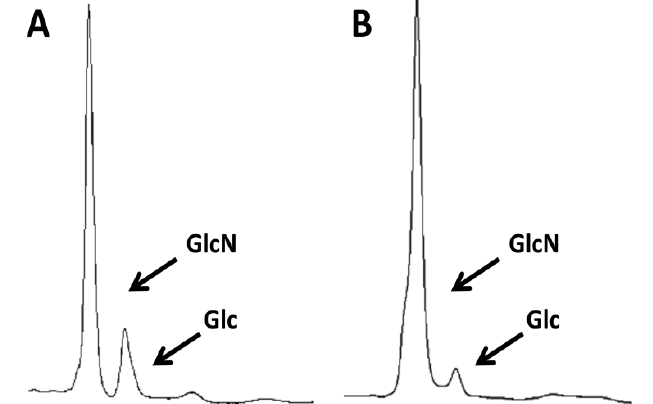
Figure 1. Purity of commercial crab chitin before and after treatment under alkali and acid conditions. Analysis of ( A ) untreated commercial crab chitin or ( B ) the same chitin that was treated by boiling twice with 5% KOH and then three times in a mix of acetic acid O . Samples were then hydrolyzed with TFAA and then the carbohydrate content and H 2 2 was analyzed by HPLC. GlcN indicates glucosamine that results from the deacetylation of the GlcNAc under the hydrolysis conditions. Glc indicates the presence of glucose from contaminating glucans, which were not completely eliminated by the chemical